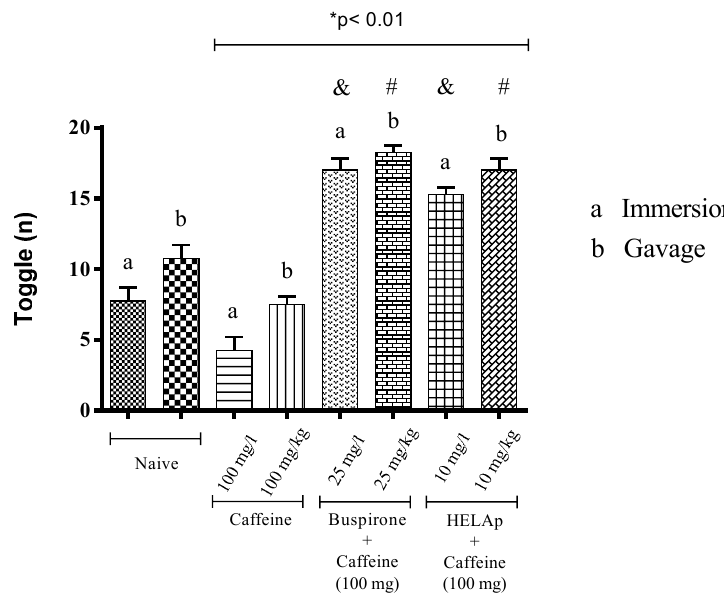
Figure 4. Effects of the hydroethanolic extract from A. polystachya , buspirone, and caffeine on zebrafish behavior in the scototaxis test (toggle) using immersion and oral (gavage) administration. Data are presented as mean ± SEM (n = 4/groups); * p < 0.01 vs. naive fishes; & p < 0.01 vs. caffeine immersion; # p < 0.01 vs. oral caffeine administration. Statistical analysis was performed through one- way ANOVA followed by the post-hoc Tukey test.